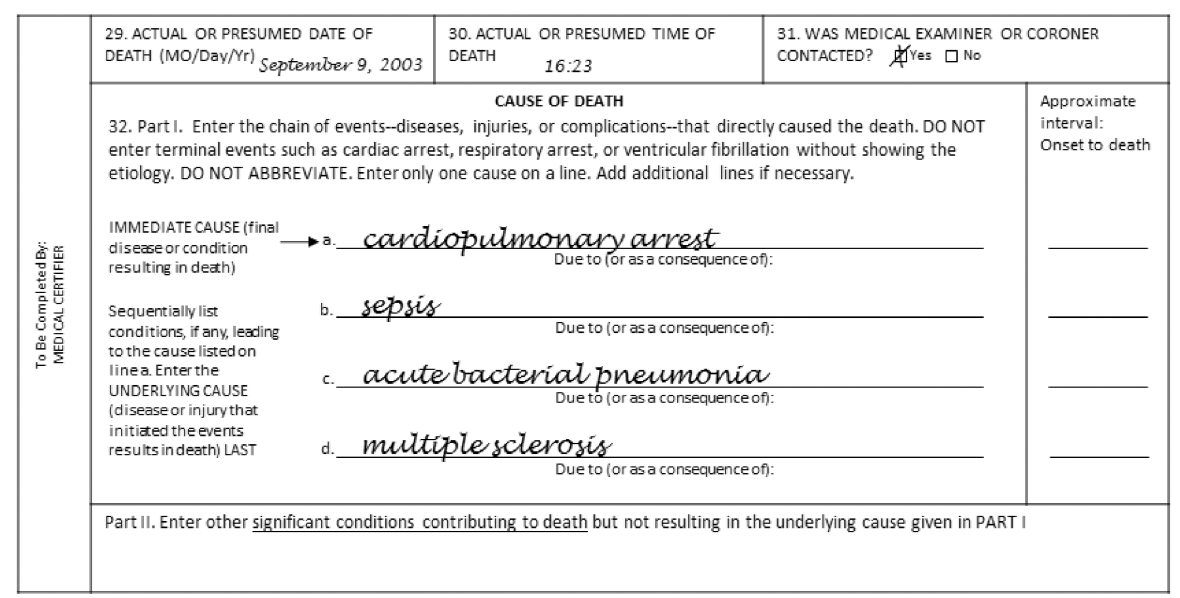
Figure 1. Sample death certificate. A hypothetical death certificate for a deceased patients with multiple sclerosis (MS) based on the standard death certificate format. [8] For this patient, the immediate cause of death (COD) would be cardiopulmonary arrest and the underlying COD would be MS. However, sepsis would be considered the principal COD.